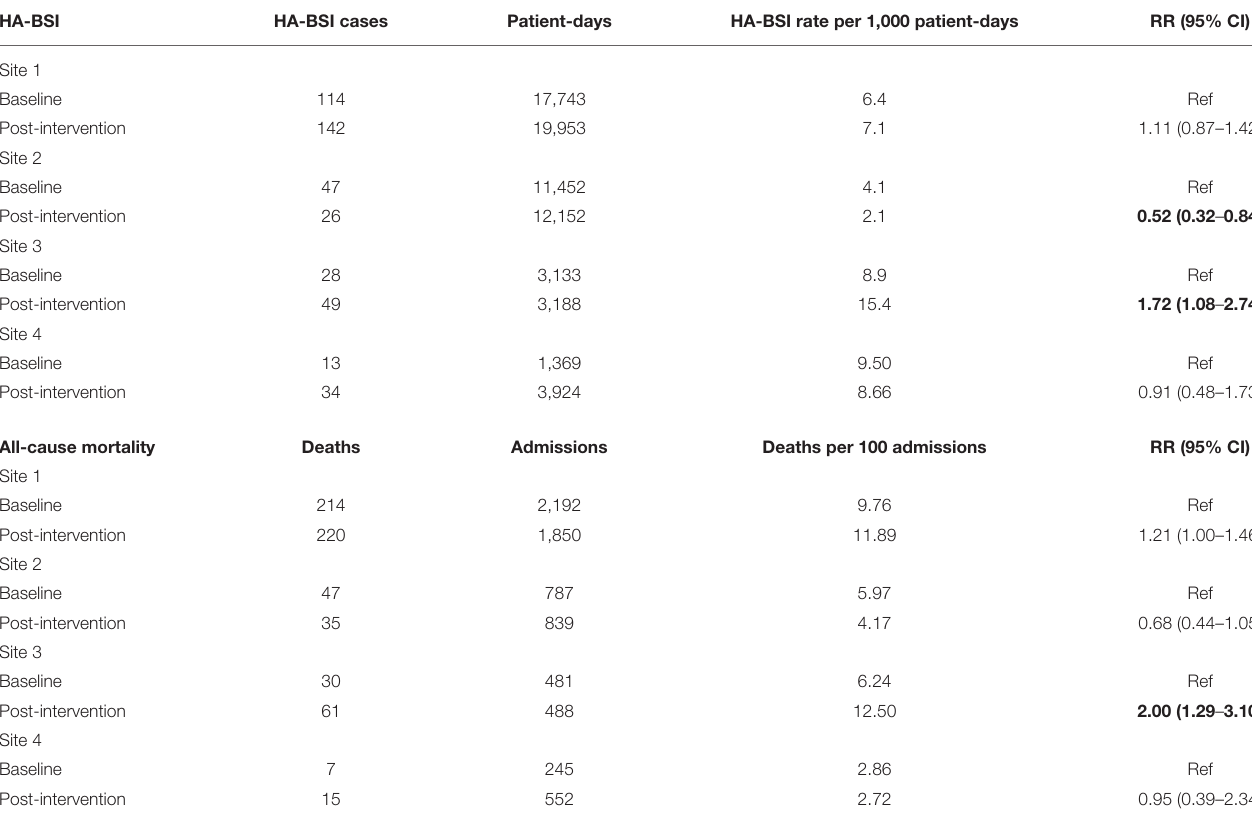
TABLE 3 | Healthcare-associated bloodstream infection rate and all-cause mortality at baseline and post-intervention, by site.